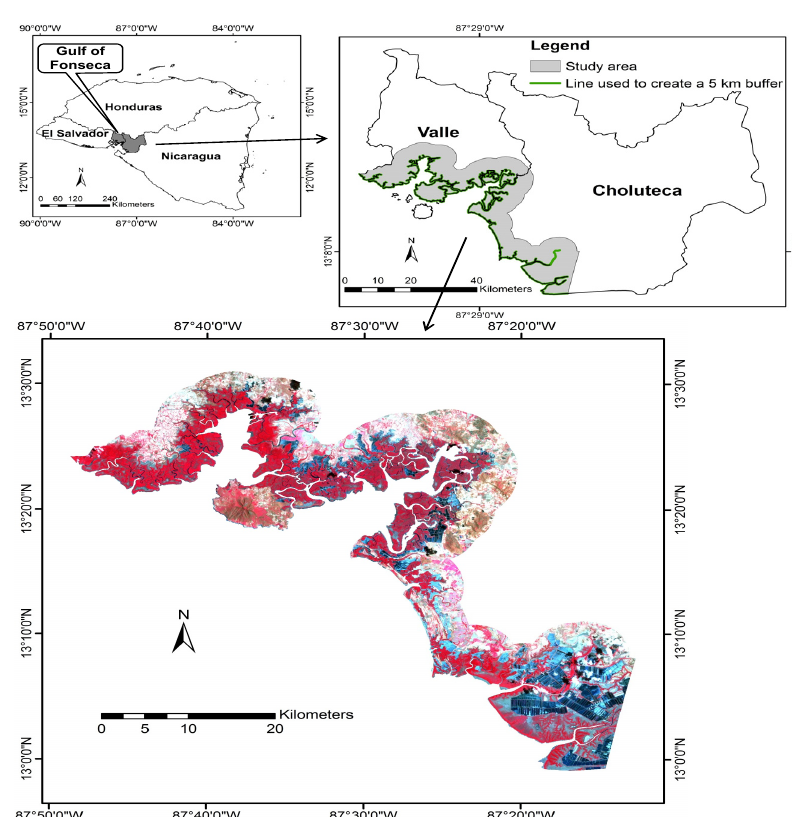
Figure 1. Map of the study area with a reference to the national geography of Honduras in Central America. The green line (a part of Honduras boundary) was used to generate the study area within a buffer of 5 km. The inset shows the 2013 false-color Landsat image (RGB = 543). The bright red generally relates to mangrove